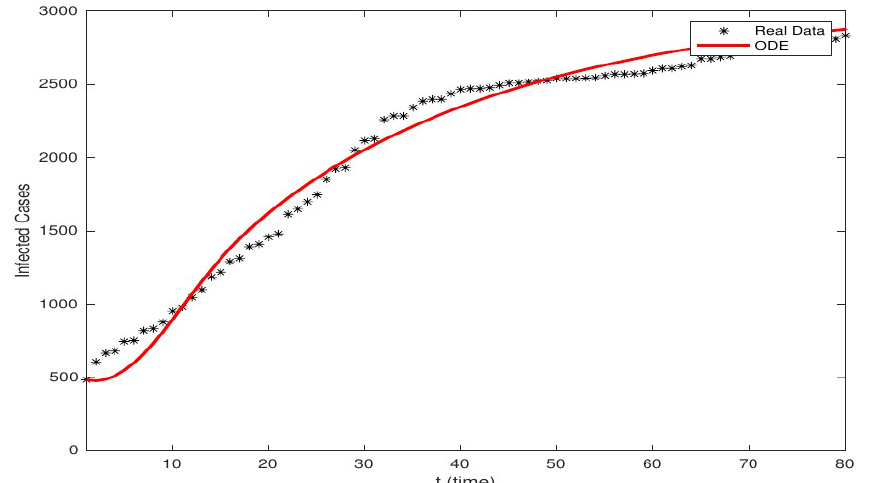
Figure 2. Fitting of the deterministic model with the Ebola virus statistical data by using the values of parameter from Table